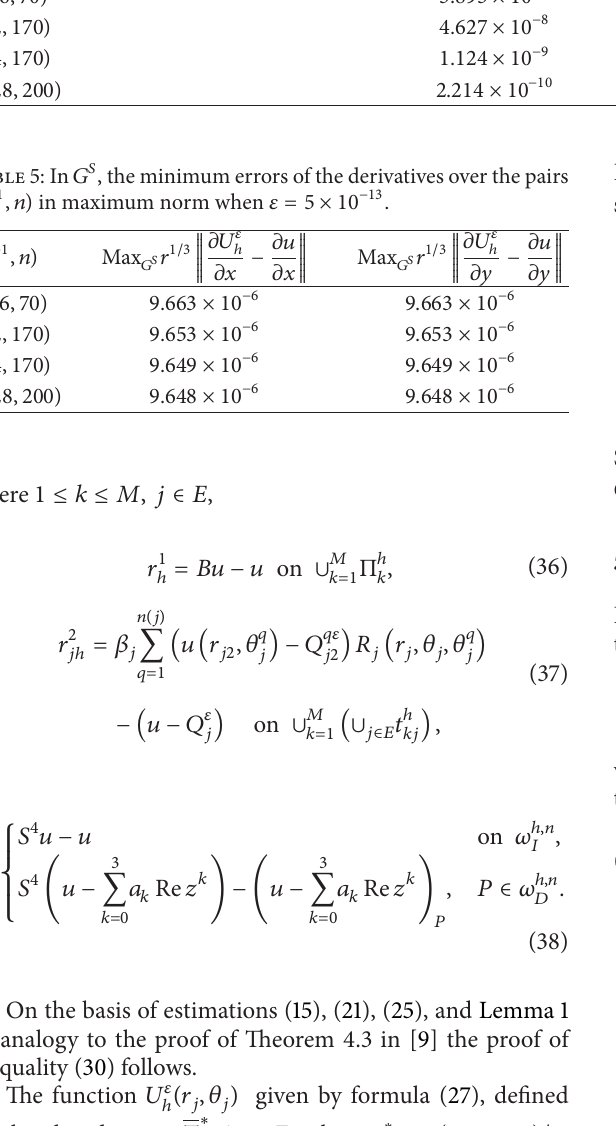
󵄩󵄩󵄩󵄩󵄩󵄩󵄩󵄩𝜕𝑈 𝑟 1/3 𝐺 𝑆 ∩ {𝑟≥0.2}